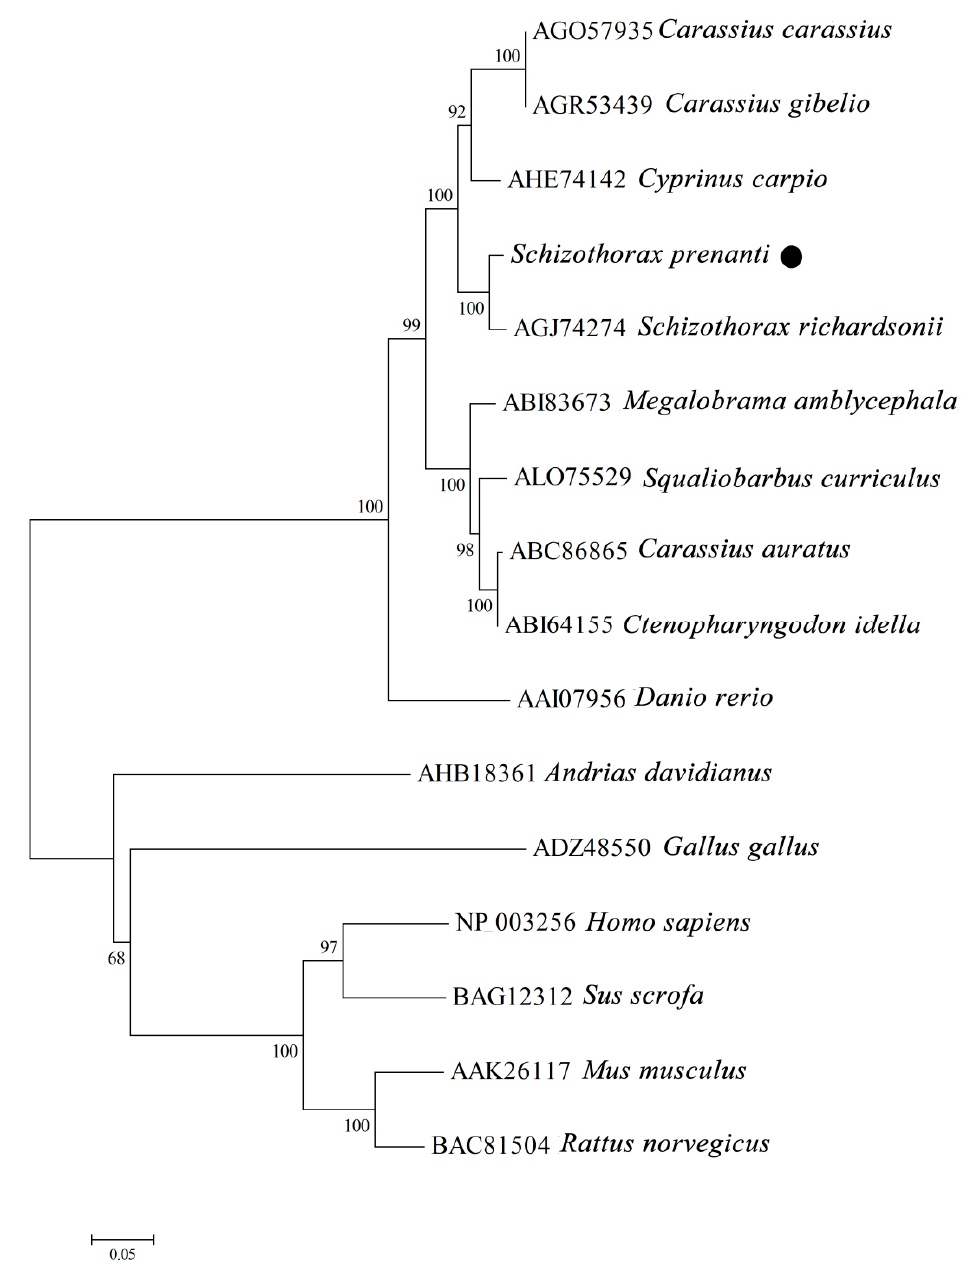
Figure 4. Phylogenetic tree of relationships between S. prenanti TLR3 and other vertebrates. Tree was constructed by neighbor-joining method using MEGA 4.0 software. Numbers at nodes indicate proportions of bootstrapping after 1,000 replications. S. prenanti TLR3 .